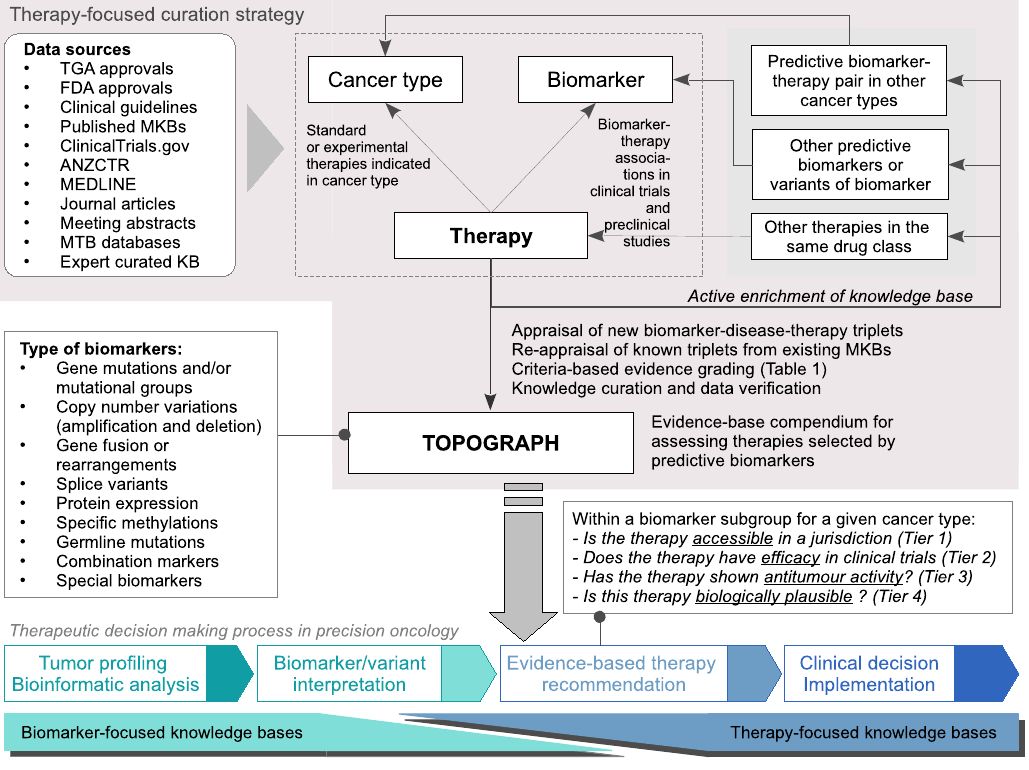
Fig. 1 Method of data review and curation. The strategy used in curating TOPOGRAPH. TGA Therapeutic Goods Administration (Australia), FDA Food and Drug Administration of United States, ANZCTR Australia and New Zealand Clinical Trial Registry, KB knowledge base.